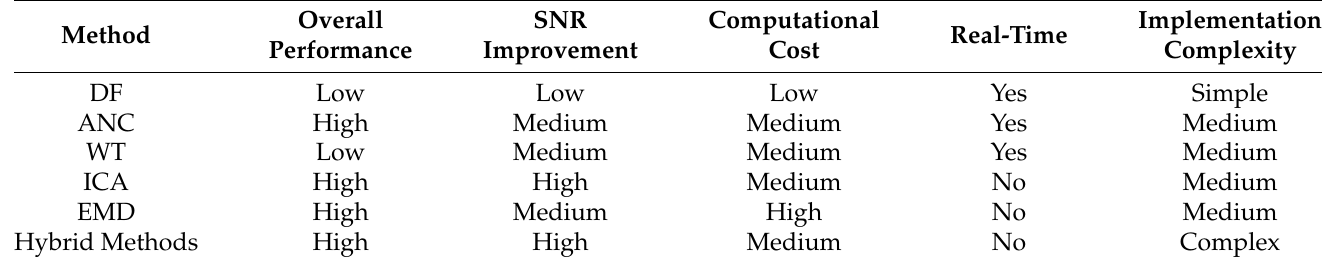
Table 1. Summary of the EMG signal processing